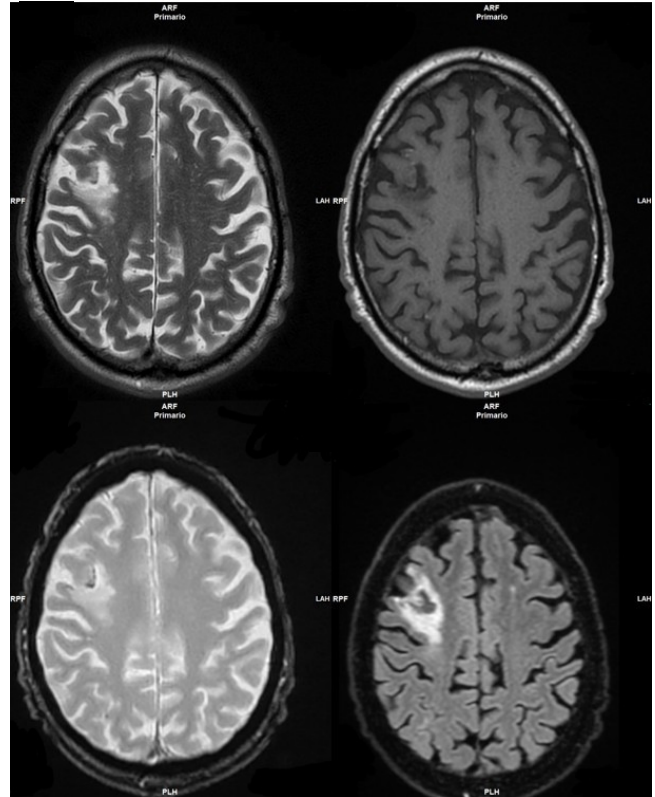
Figure 1. Hyperintense area in the fronto-temporal-insular left lobe.